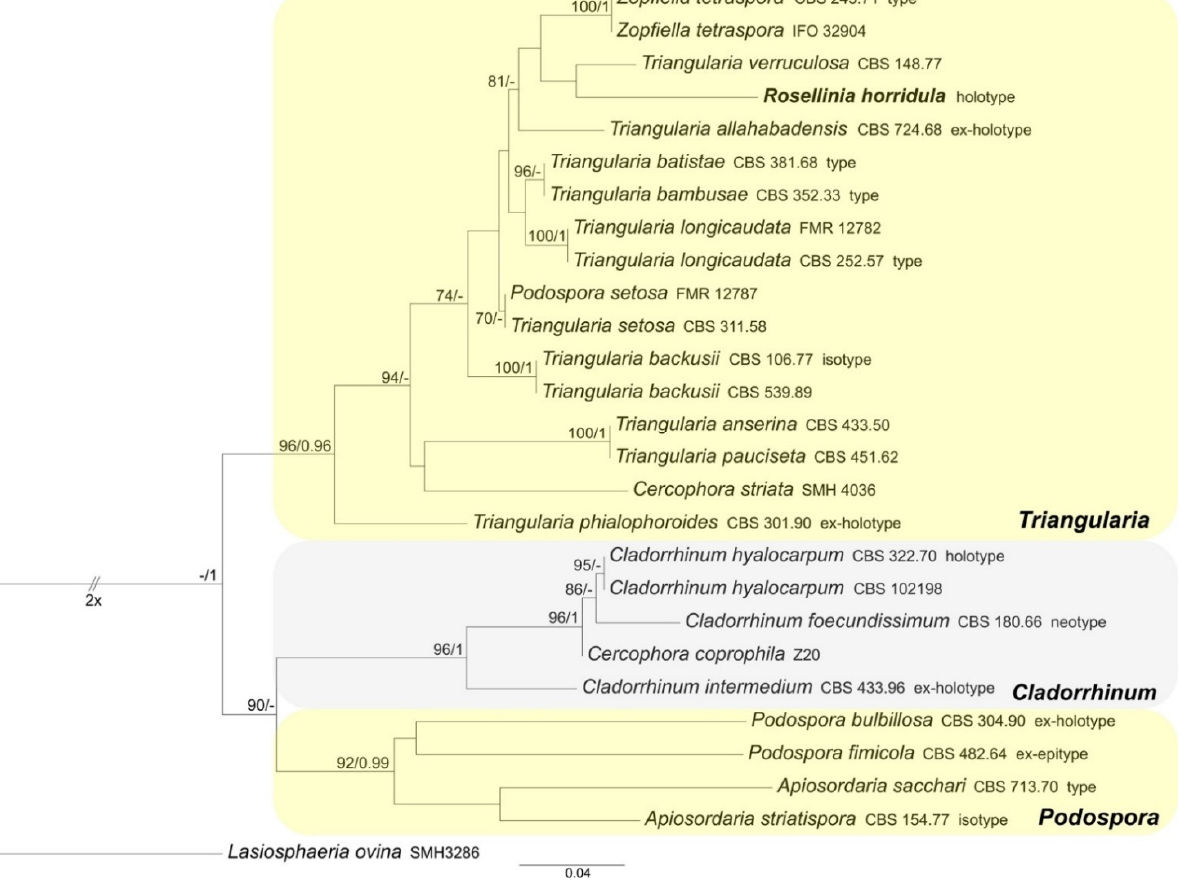
Figure 2. RAxML phylogram obtained from ITS sequences of selected Triangularia , Cladorrhinum and Podospora (Podosporaceae) species. Lasiosphaeria ovina (Lasiosphaeriaceae) was selected as the outgroup taxon. MLB values ≥ 70% (left) and BPP values ≥ 0.95 (right) are shown on the branches. Newly obtained sequence is reported in bold .